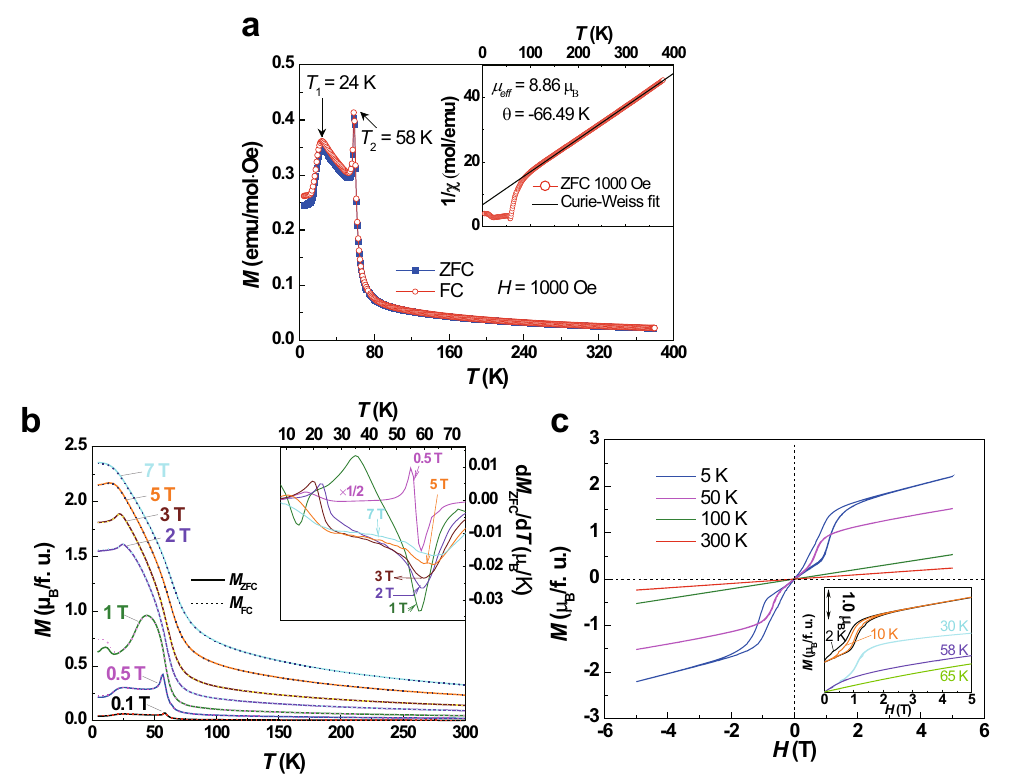
Fig. 3 Magnetic properties of HP-CTO. a Thermal evolution of the ZFC and FC mode magnetization ( M ) and the inverse susceptibility ( χ − 1 ) (inset) of HP-CTO collected with a fi eld of H = 0.1 T. b M ( T ) curve at a series of magnetic fi elds between 0.1 and 7 T. Inset shows the numerical d M /d T derivatives for the ZFC- M ( T ) curves in the main part of the fi gure. The H = 0.5 T curve is reduced by the factor 1/2 for clarity. c Isothermal magnetization curves measured at 5, 50, 100, and 300 K between − 5 and 5 T. Inset shows the M – H curves measured at 2, 10, 30, 58, and 65 K between 0 and 5